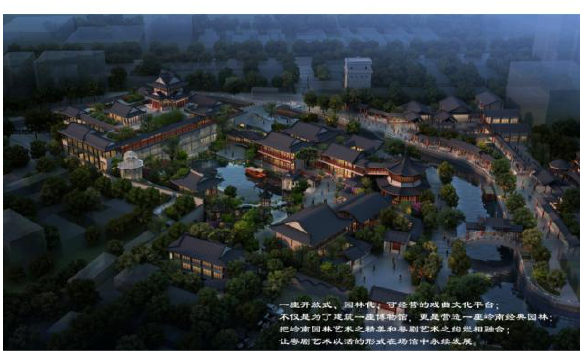
Fig.2 General Plan of the Guangzhou Cantonese Opera Art Museum Fig. 1 Design Sketch of the Guangzhou Cantonese